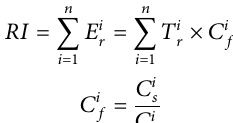
Frontiers in Environmental Science |